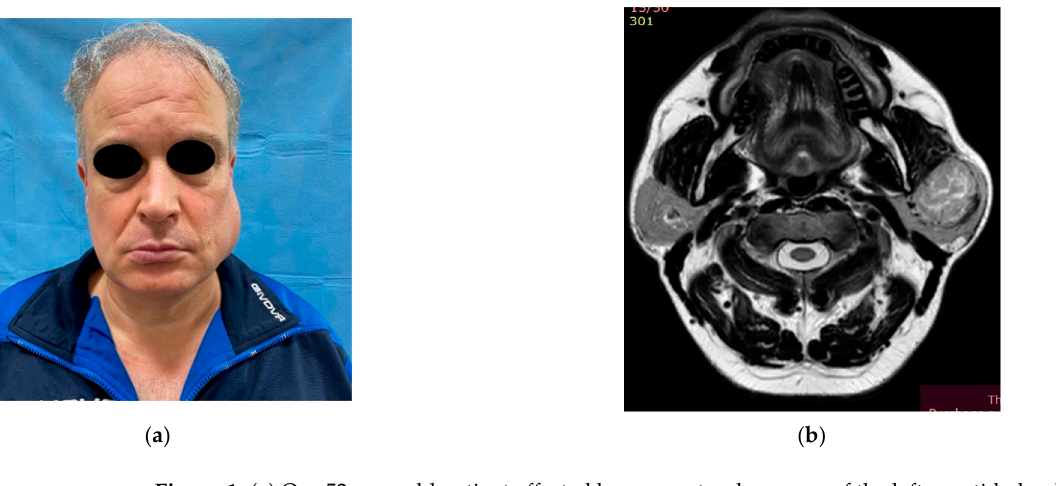
Figure 1. ( a ) Our 52-year-old patient affected by a symptomless mass of the left parotid gland ( b ) The T.C. scan of the facial massif performed on the patient. T.C. scan of the facial massif performed on the